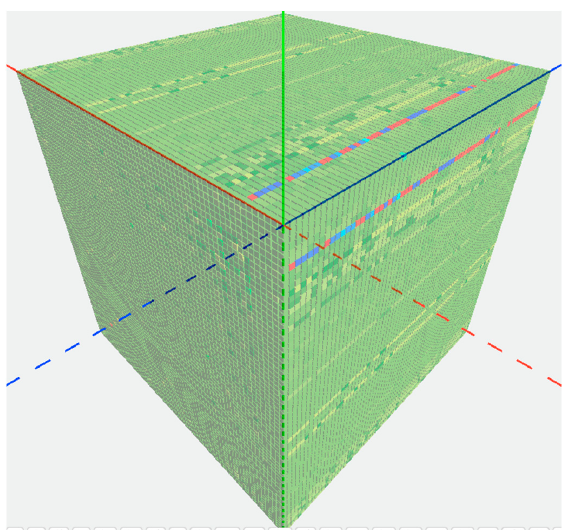
Figure 4. Visualization of a 72 × 72 × 72 matrix in the developed pilot system. The rows of red and blue cells are corresponding to the O-H plane, and they highlight different elements’ association with hydrated (i.e., O–H bearing) minerals.